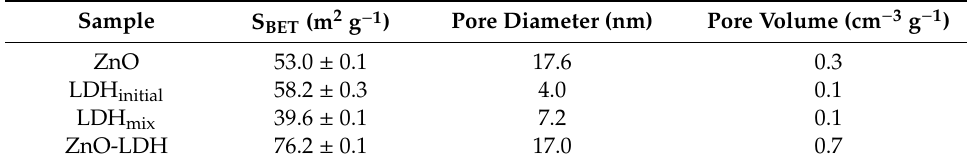
Figure 3. Transmission electron microscopy images (200 kV and ×150,000–500,000 magnification) ( a ) ZnO, ( c ) LDH initial , ( e ) ZnO-LDH and SEM micrographs ( b ) ZnO, ( d ) LDH initial , ( f ) ZnO-LDH. Table 4. Specific surface area, pore diameter, and cumulative pore volume of ZnO, Mg2Al-CO3 (LDHinitial), ZnO-LDH composite, and a mix of ZnO and LDHinitial